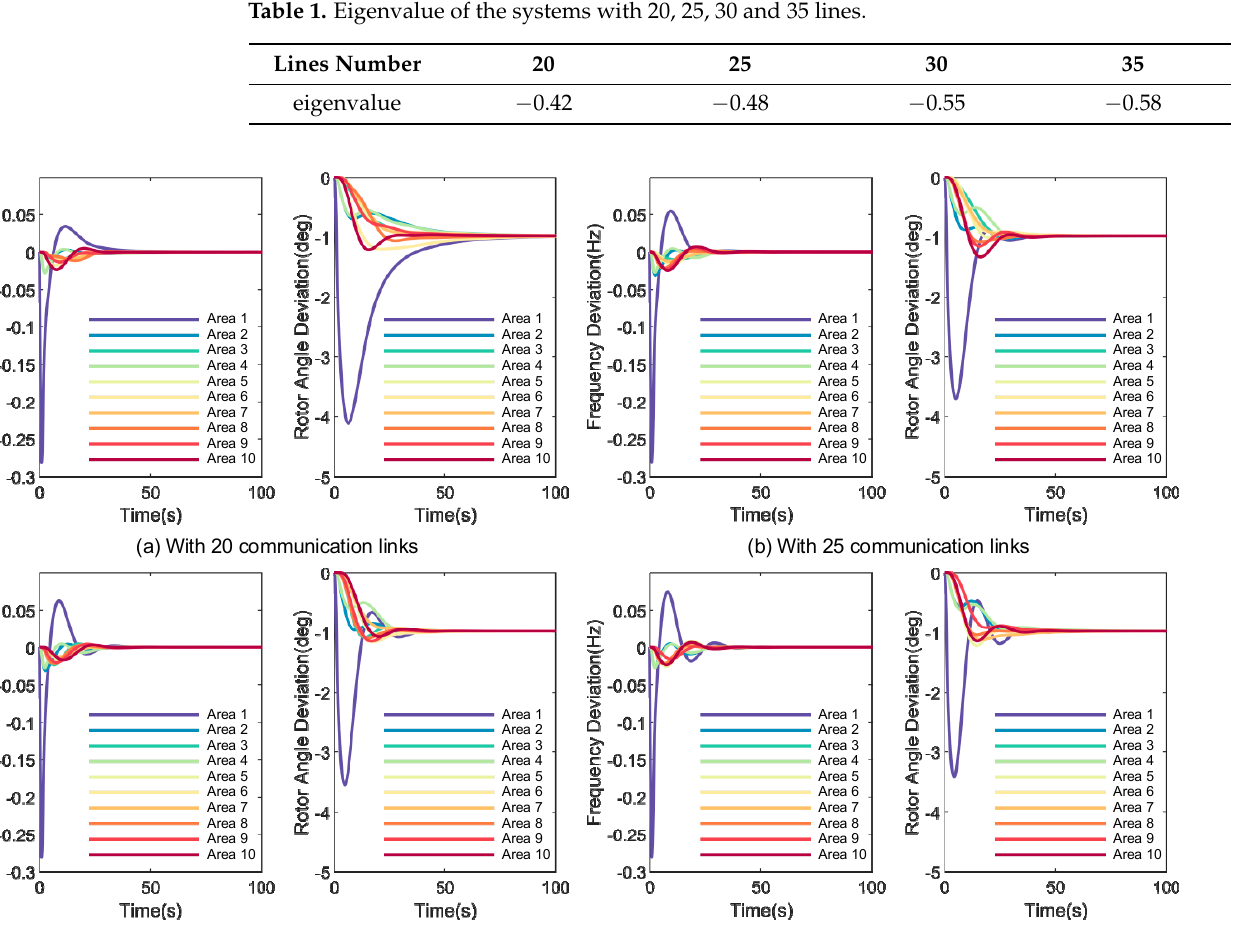
Figure 12. Frequency deviation and rotor angle deviation of the proposed method and the compared method with different numbers of communication links in frequency event